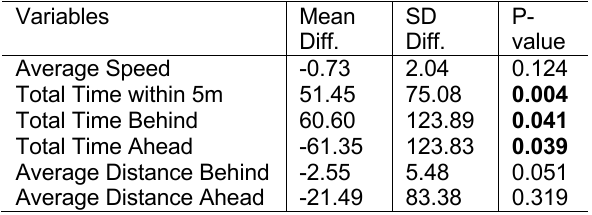
Table 2. Results of user